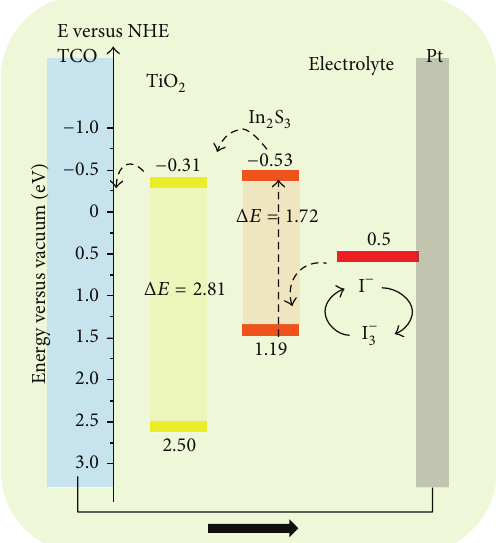
Scheme 1: Model for the potential energy diagram expected from the results of the CV curves and UV-visible